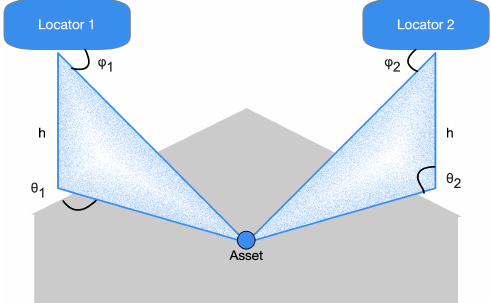
Figure 3. A transmitting resource’s three-dimensional position can be calculated by estimating the signals’ AoA in two fixed locators. If the locators’ absolute coordinates are known, it is also possible to calculate the absolute coordinates of the resource it